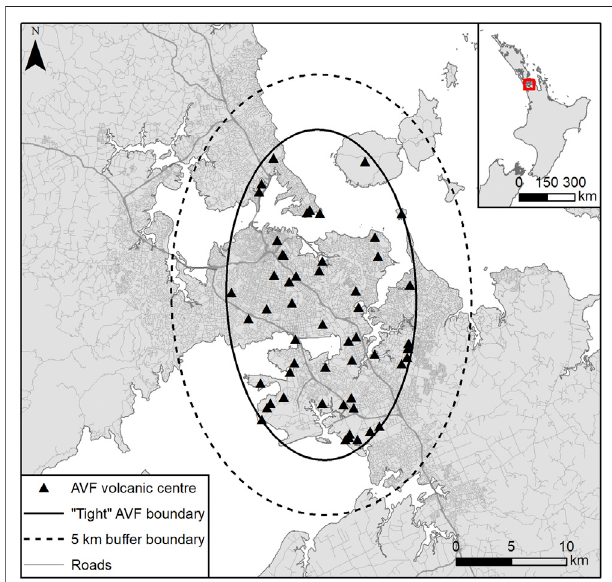
FIGURE 1 | Auckland Volcanic Field vent locations with “ tight ” and 5 km buffer boundaries from Runge et al. (2015) to illustrate the